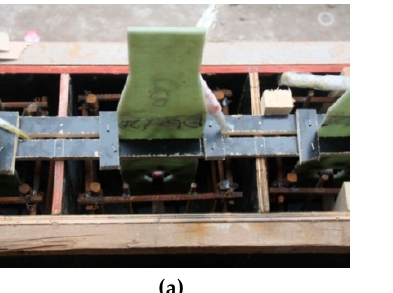
Figure 2. Specimen’s layout. ( a ): Layout of specimen; ( b ): Pultruded GFRP plates.